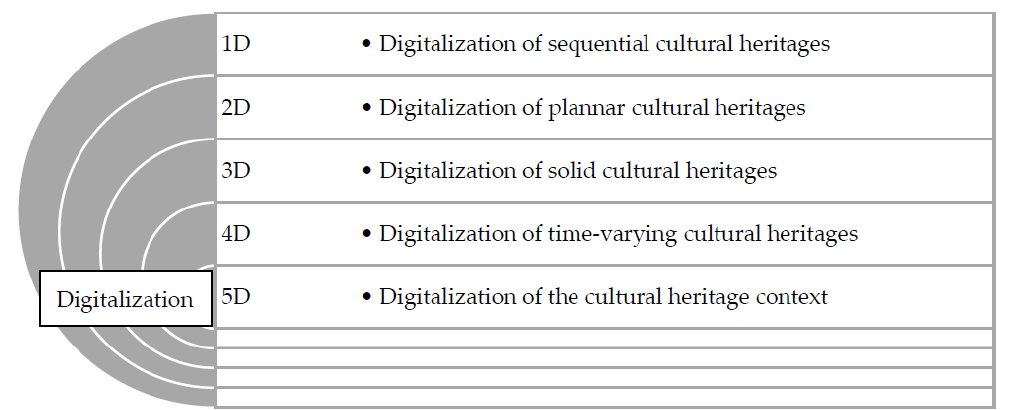
Figure 12. Digitalization of Cultural Heritages.